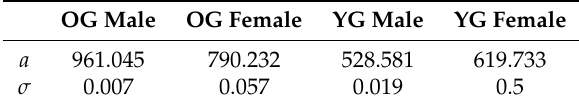
Table 2. Parameters of the marginal survival